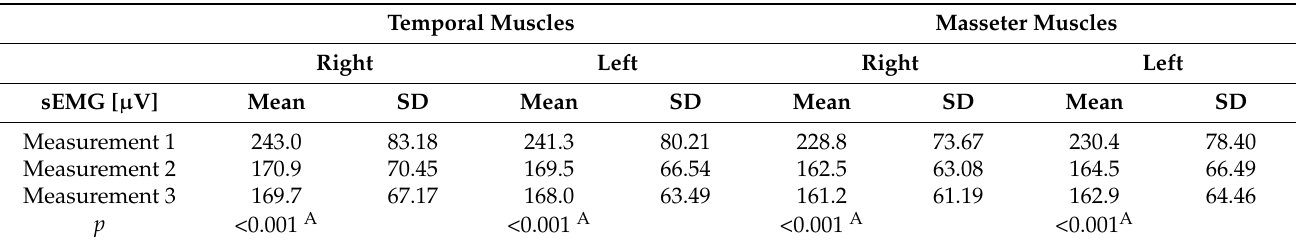
Table 5. Mean values of electric potentials [ µ V] of the anterior part of temporal muscles and masseter muscles measured during the first examination and control tests in group